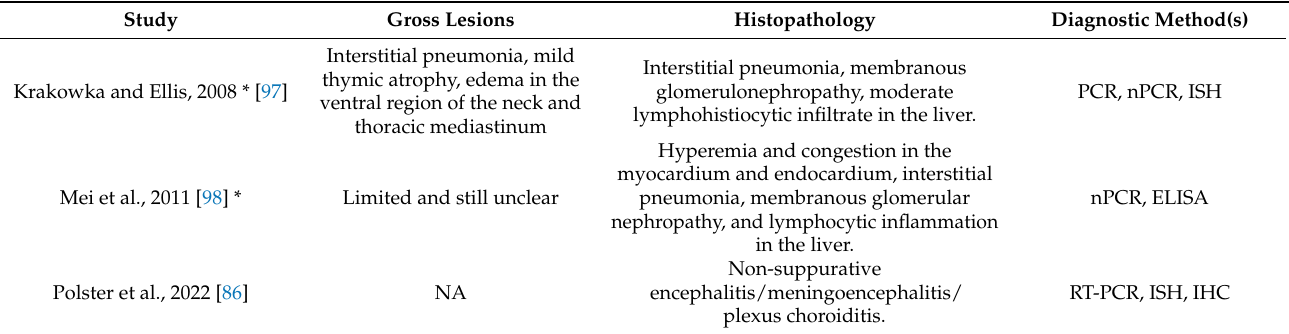
Table 2. Scientific studies describing the gross and histological lesions and diagnostic methods applied for Torque teno sus virus